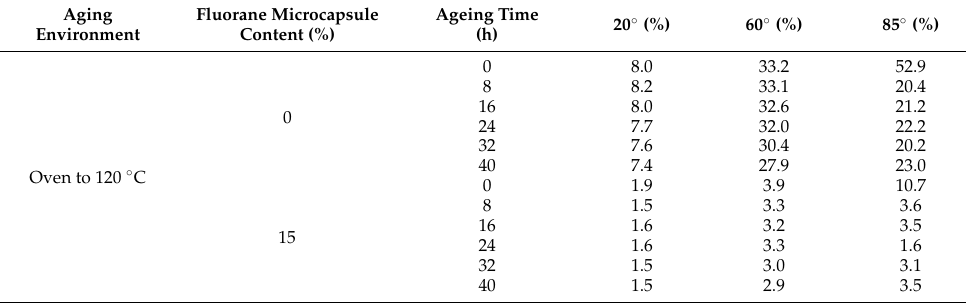
Table 11. Effect of aging time on 60 ◦ gloss of the